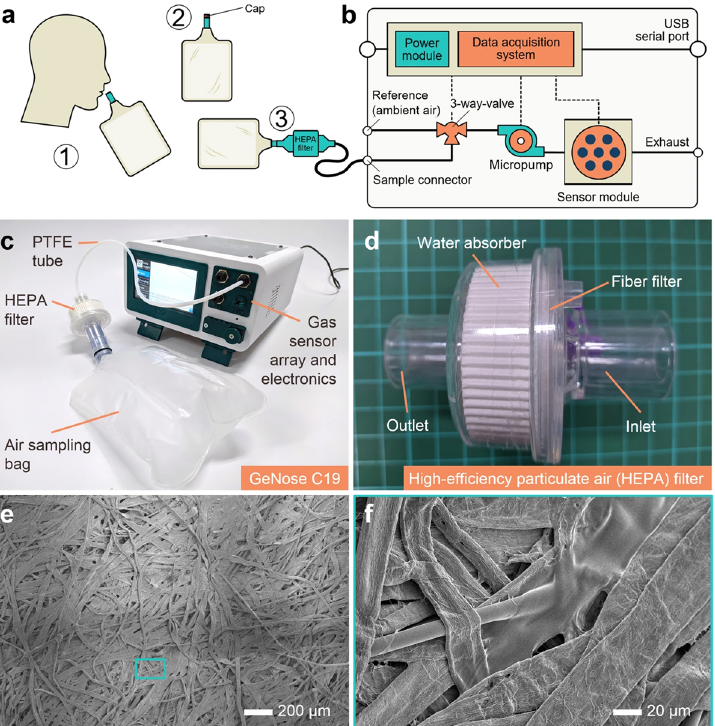
Figure 11. ( a ) Schematic of the GeNose C19 off ‐ line breath sampling pipeline: (1) inhaling air via the nose and then exhaling it through the mouth into a sampling bag, (2) sealing or shutting the sampling bag lid to prevent collected air leakage, and (3) directly inserting the sampling bag into the electronic nose inlet. ( b , c ) GeNose C19 integrated with a high ‐ efficiency particulate air (HEPA) filter and an air sample bag through a flexible medical ‐ grade polytetrafluoroethylene (PTFE) tube with a 4 mm outer diameter. The electronic nose is made up of numerous major electrical and mechanical components. The sensor module is made up of ten separate sensing devices stacked in an array. ( d )